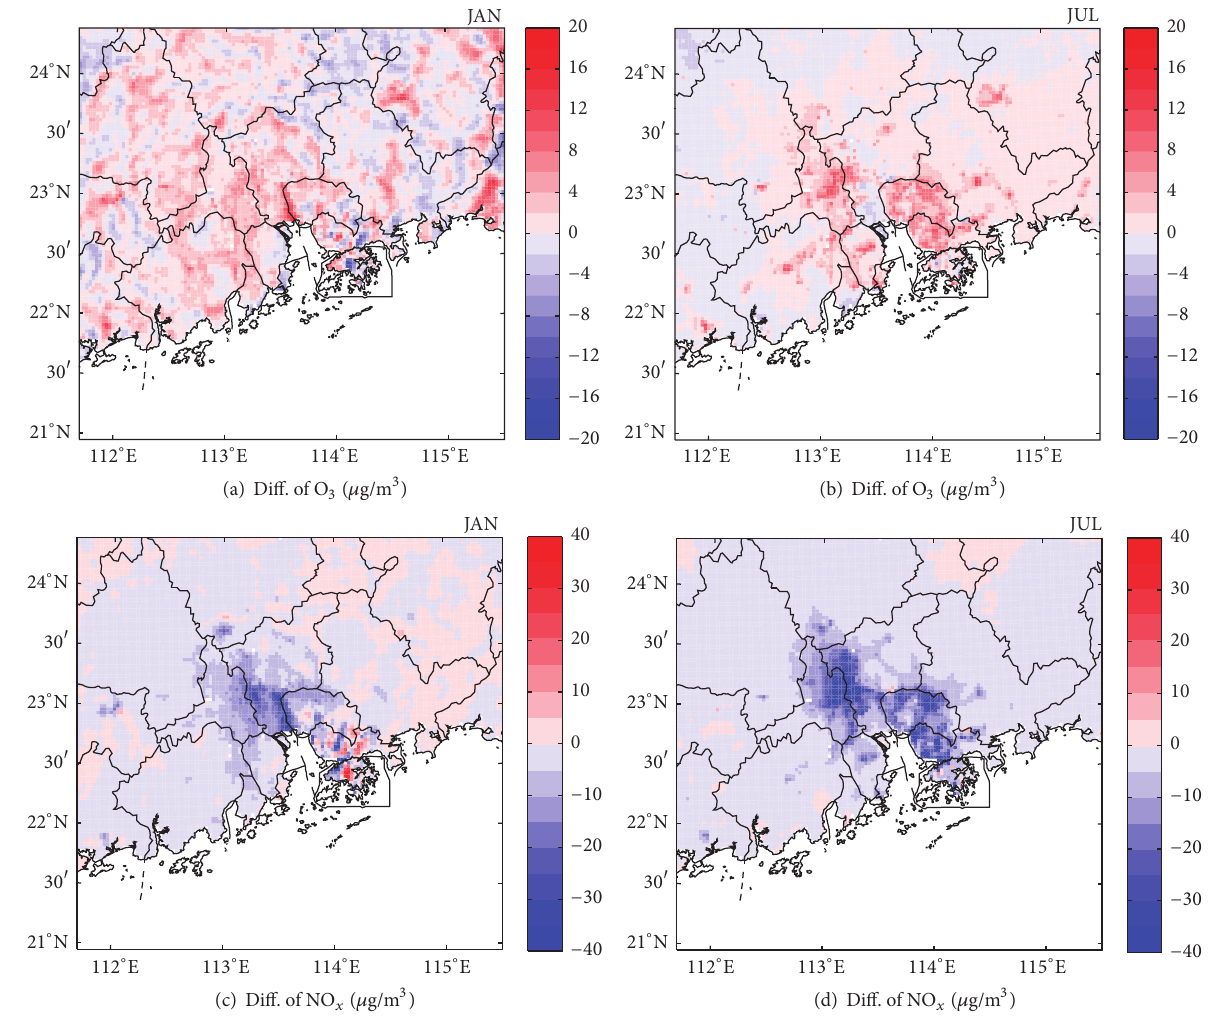
Figure 7: Spatial distribution of monthly-average O 3 concentration differences ( 𝜇 g/m 3 ) (a, b) and NO 𝑥 concentration differences ( 𝜇 g/m 3 ) (c, d) between the GLC2009 case and the GLC2000 case (differences = GLC2009 −